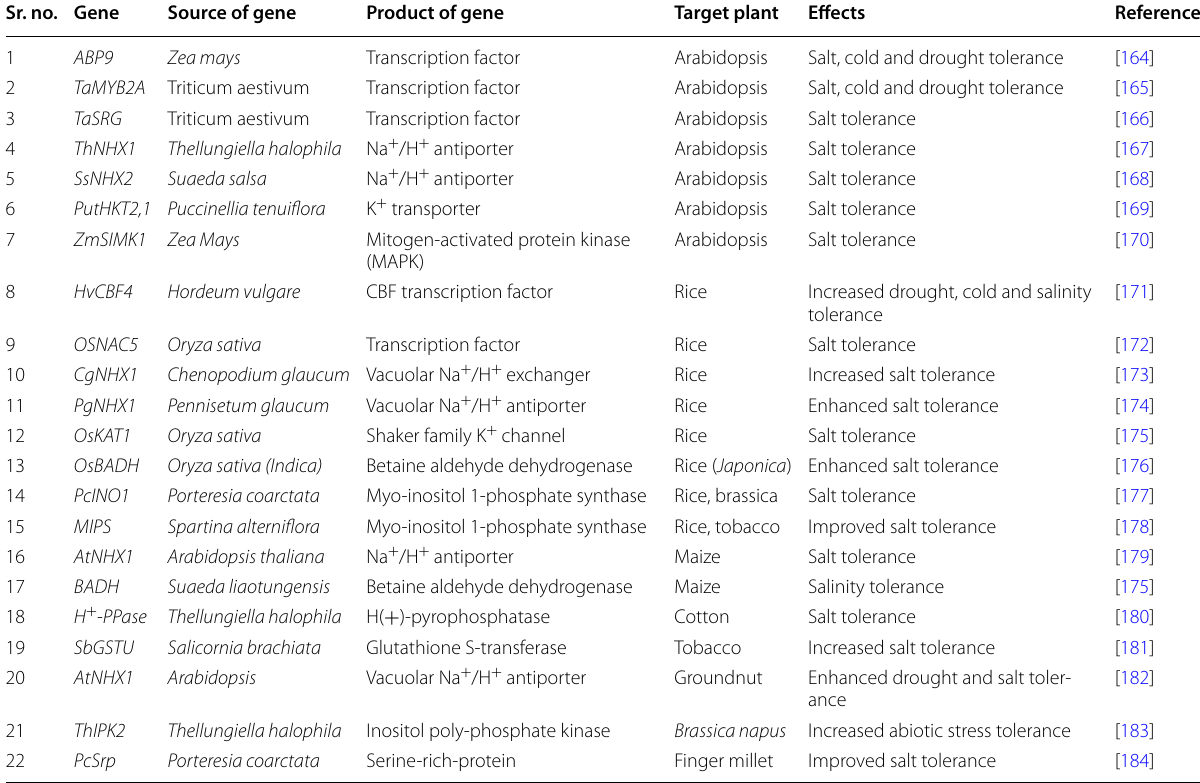
Table 3 Involvement of genes obtained from different crops and their role in stress tolerance Sr. no.